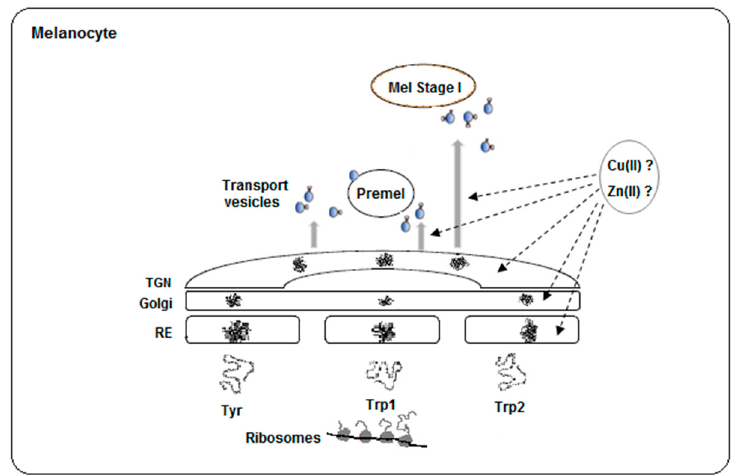
Figure 3. Scheme of the traffic and maturation of the tyrosinase family. Nascent polypeptides coming from polyribosomes pass through endoplasmic reticulum (ER), Golgi and TGN (trans-Golgi network) for proper folding. Then, N -glycosylated proteins are transported to premelanosomes or melanosomes in vesicles by recognition of specific adaptor proteins to motifs at the respective C-carboxy tails. Truncation of the C-terminal may alter the pathway of the proteins. On the other hand, the location for Zn(II) or Cu(II) acquisition by apo-proteins is unknown, but different traffic might imply different metal incorporation. Experimental data indicate that the metal binding site in the tyrosinase family seems to accommodate both ions.